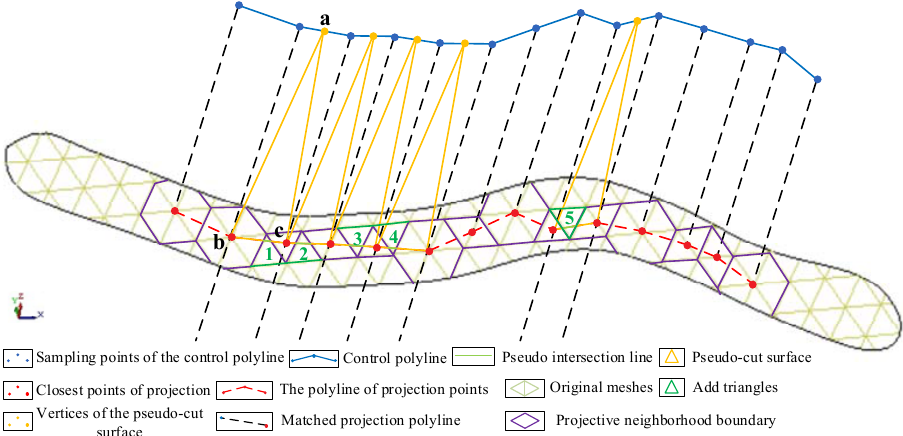
Figure 5. Determination of the intersecting triangular patches between the deformation points by constructing pseudo ‐ cut surfaces. The vertices of the pseudo ‐ cut surface are represented by ’ 𝒂 ’ to ‘ 𝒄 ’. The added triangular patches are represented by ‘ 𝟏 ’ to ‘ 𝟓 ’.